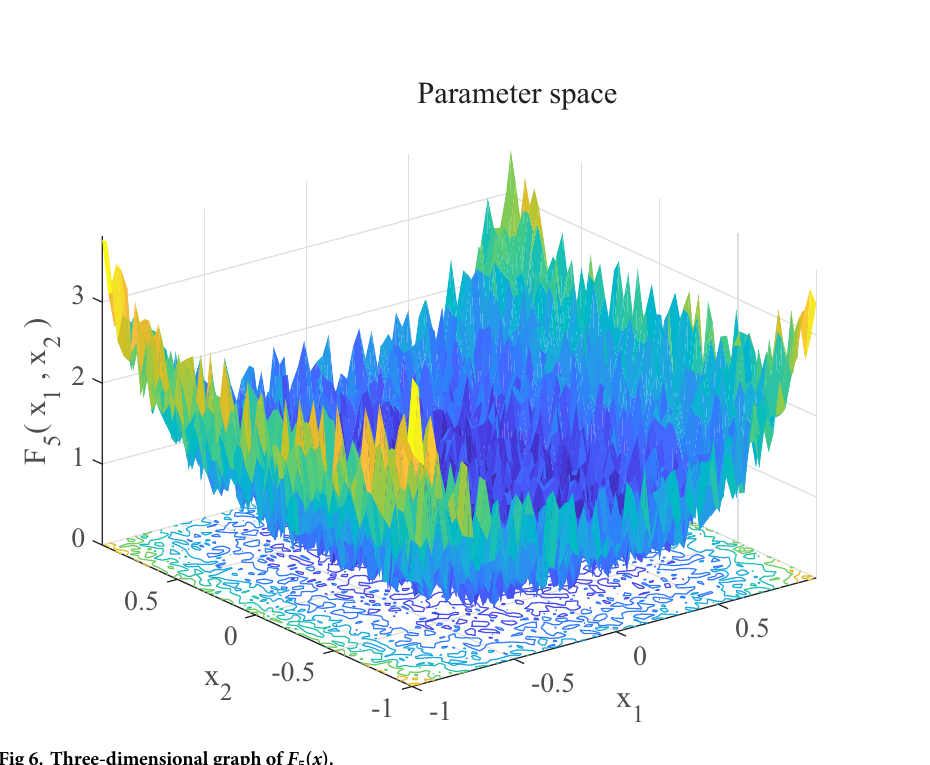
Fig 6. Three-dimensional graph of F 5 ( x